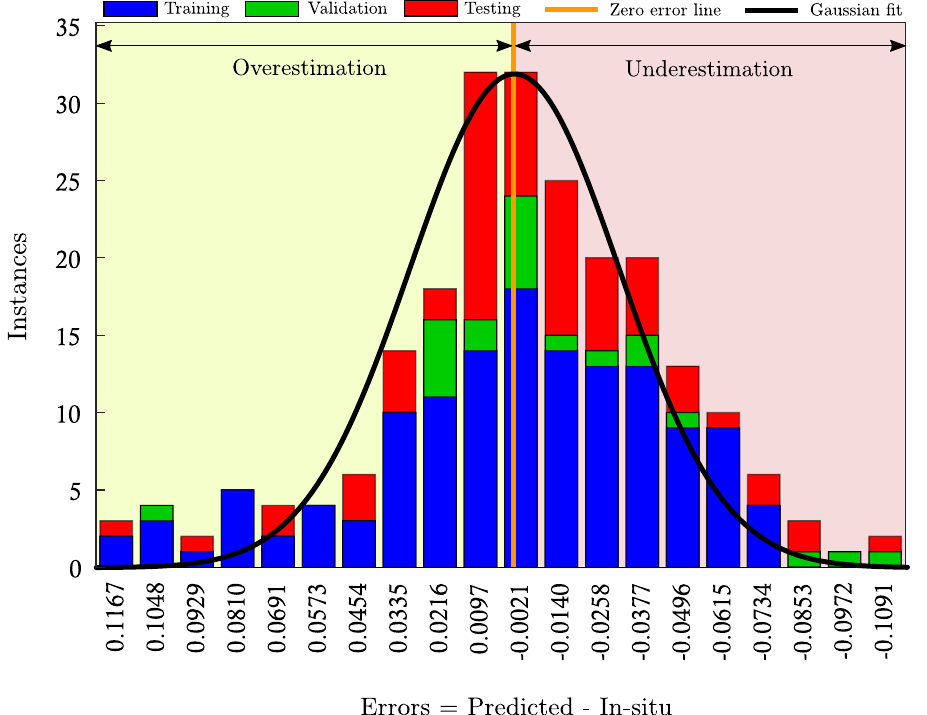
Figure 9. Error histogram (with 20 bin size) for training, validation, and testing phase. The area to the left and right of the zero error (orange) line represents overestimated and underestimated regions, respectively.